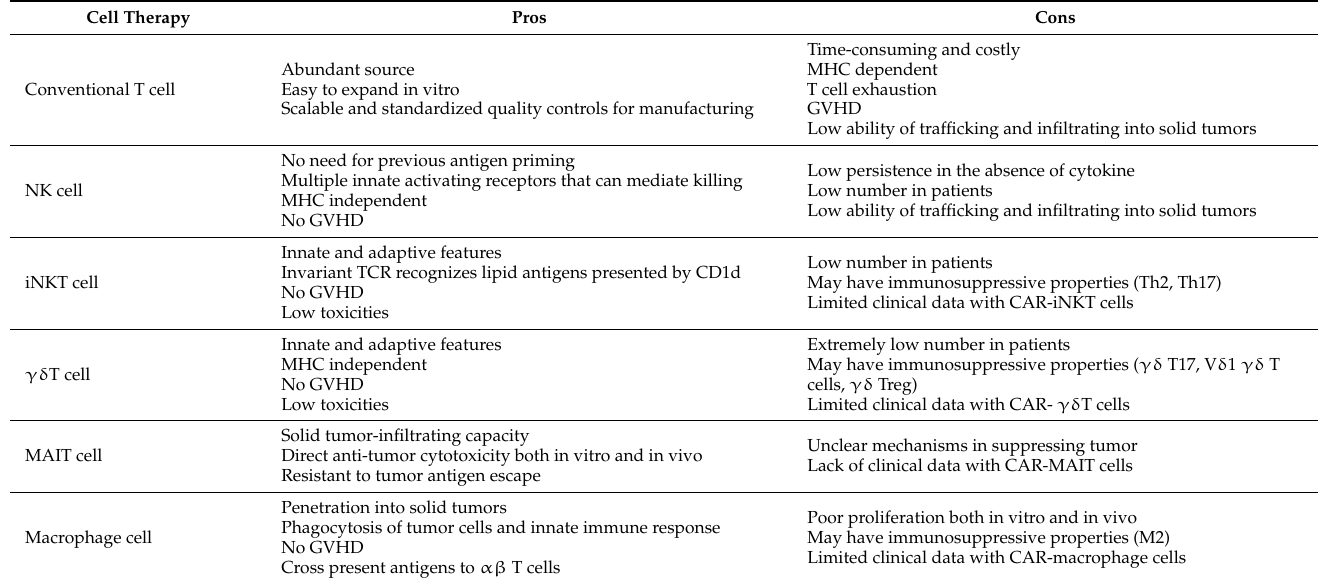
Table 2. Pros and cons of using different types of cells in cancer